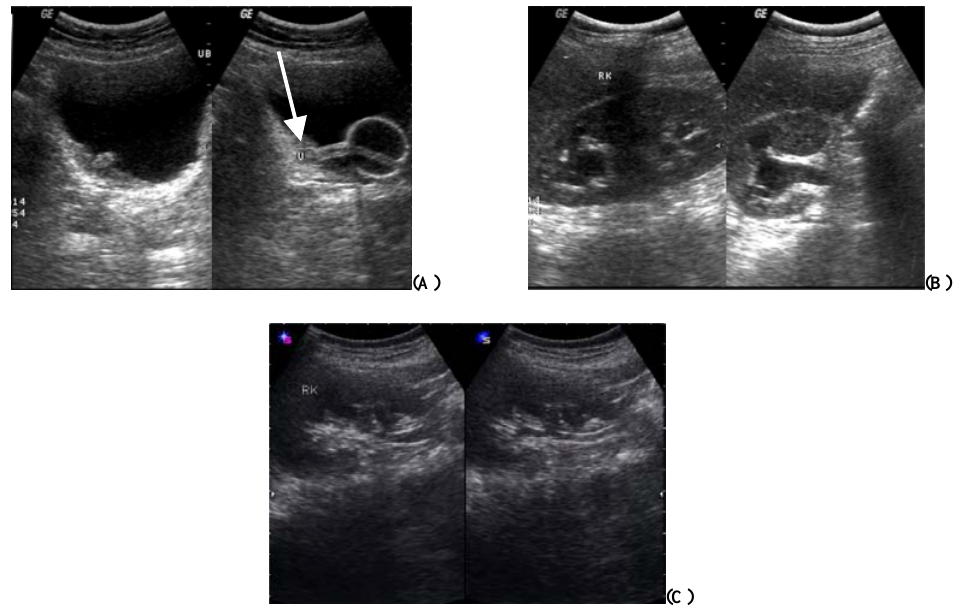
FIGURE . Abdomen ultrasound showing (A) tip of the Foley’s catheter inside the right ureter (arrow), (B) right hydroureteronephrosis, (C) hydroureteronephrosis subsided after repositioning the